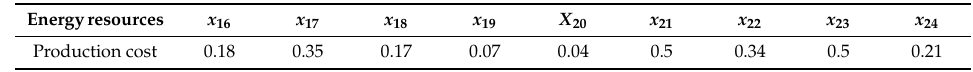
Table 8. Cost of energy production from power plants (in kWh / ha).